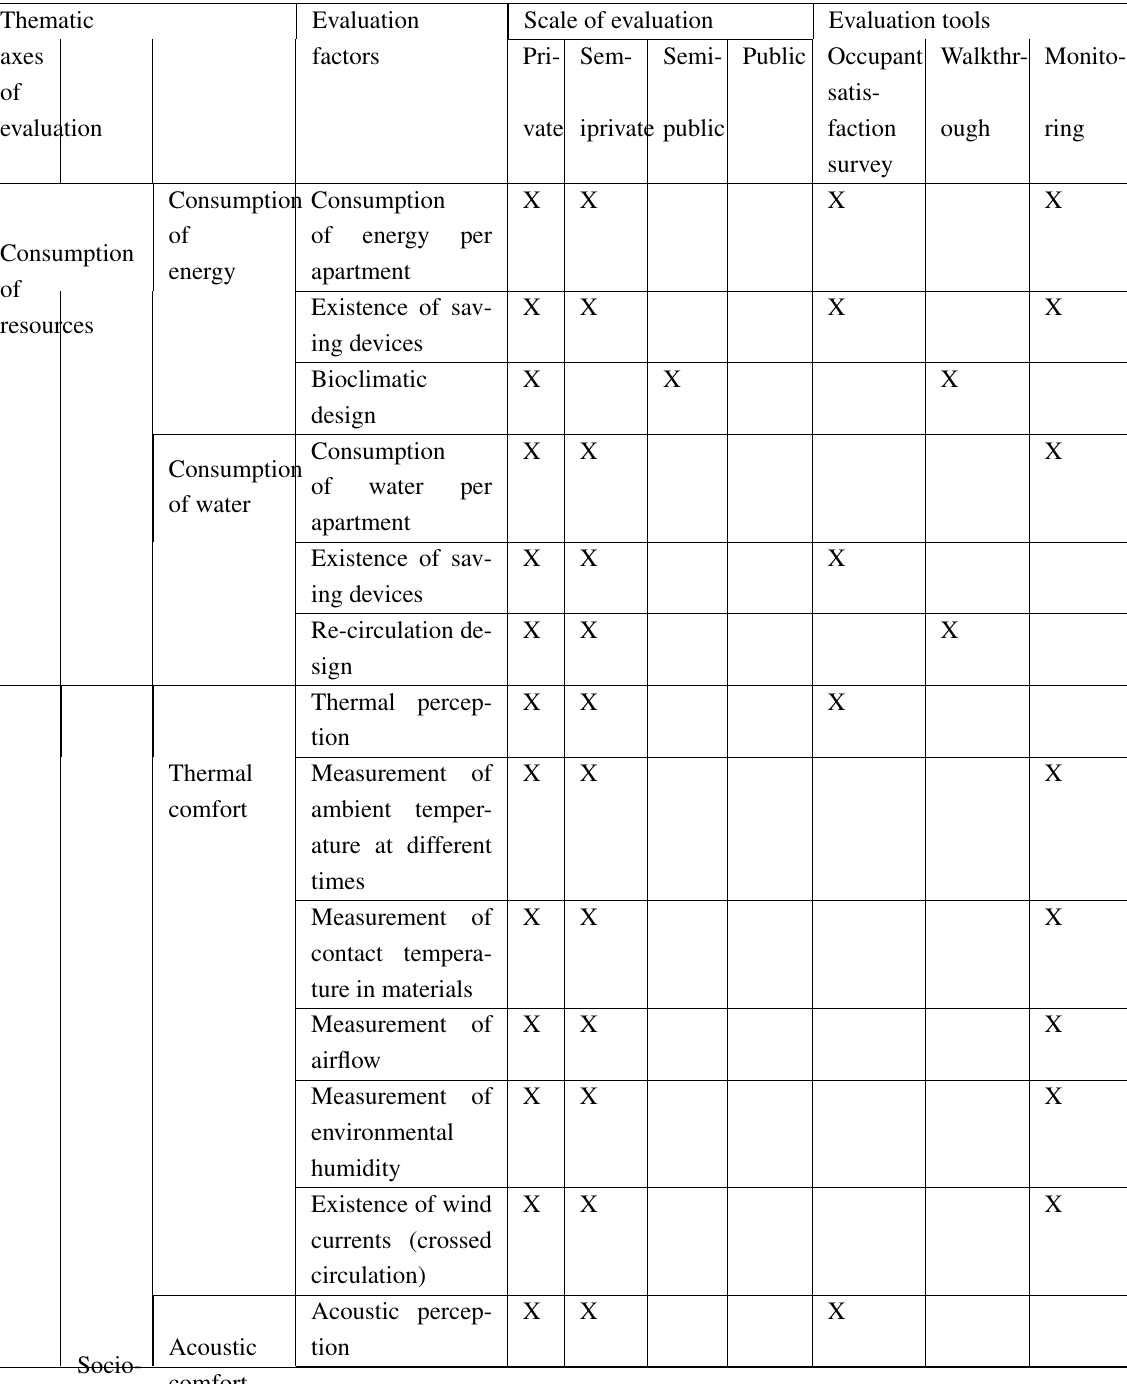
Table 4. Post Occupancy Evaluation